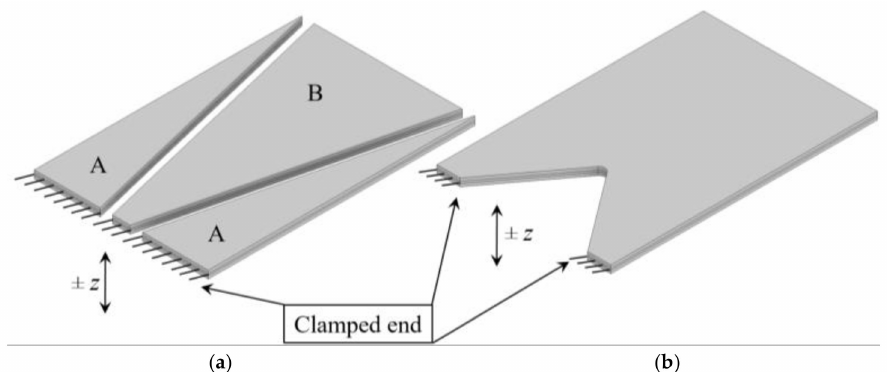
Figure 4. Segmented PEH ( a ) and PEH with a triangular notch at the clamped end ( b ), with the excitation displacement of the clamped end denoted by z